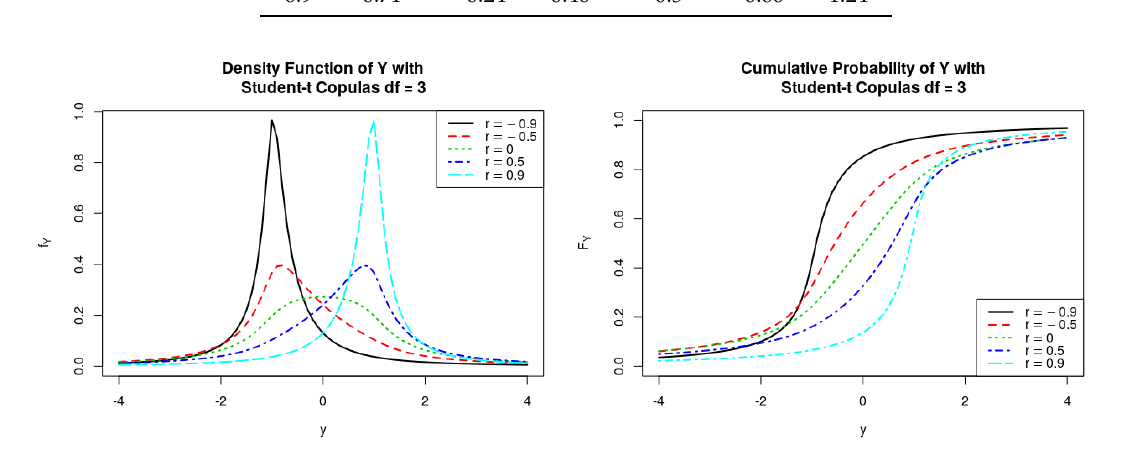
Figure 3. PDFs and CDFs of the ratio Y = X 1